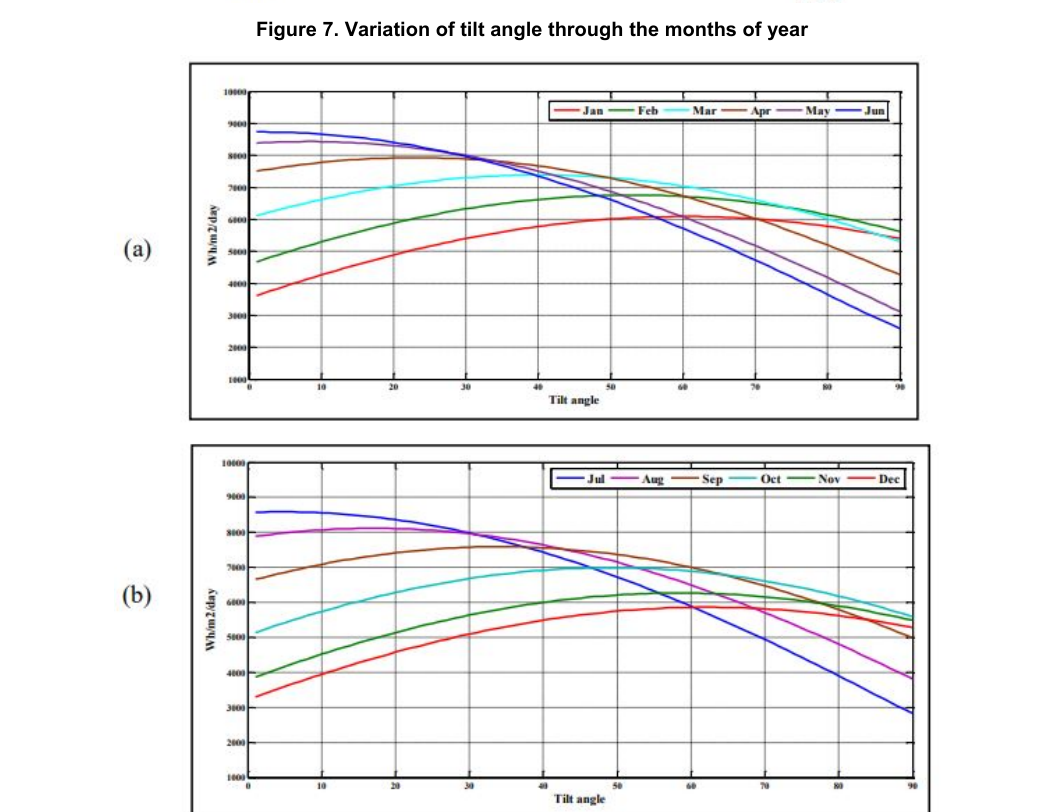
Figure [8]. Monthly average daily total solar radiation on a south facing tilted surface in Baghdad for tilt angles ranging from (0o to